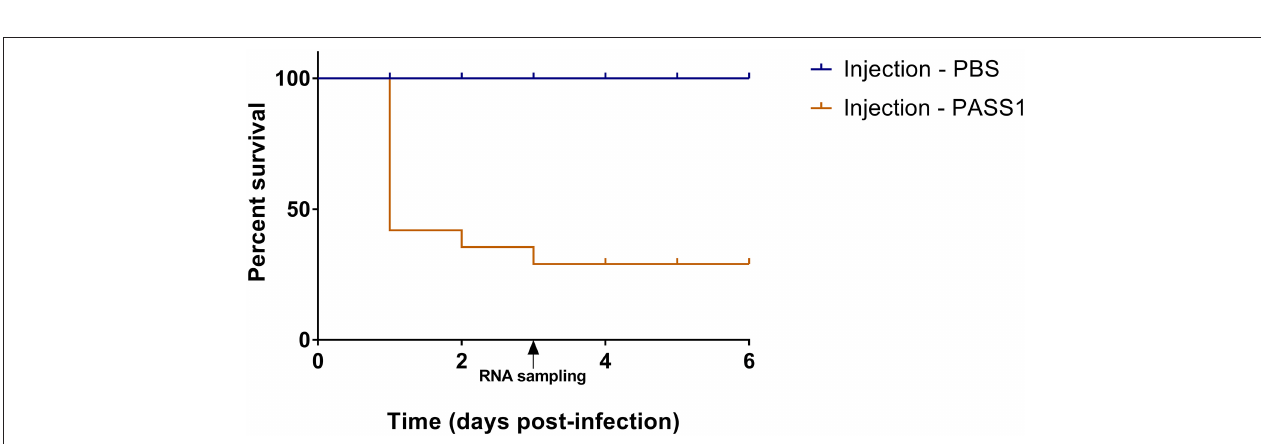
FIGURE 2 | Percentage survival of zebrafish embryos infected with P. aeruginosa PASS1. Kaplan-Meier representation of the survival of zebrafish embryos infected with PASS1 and mock-infected with PBS via injection into the duct of Cuvier.